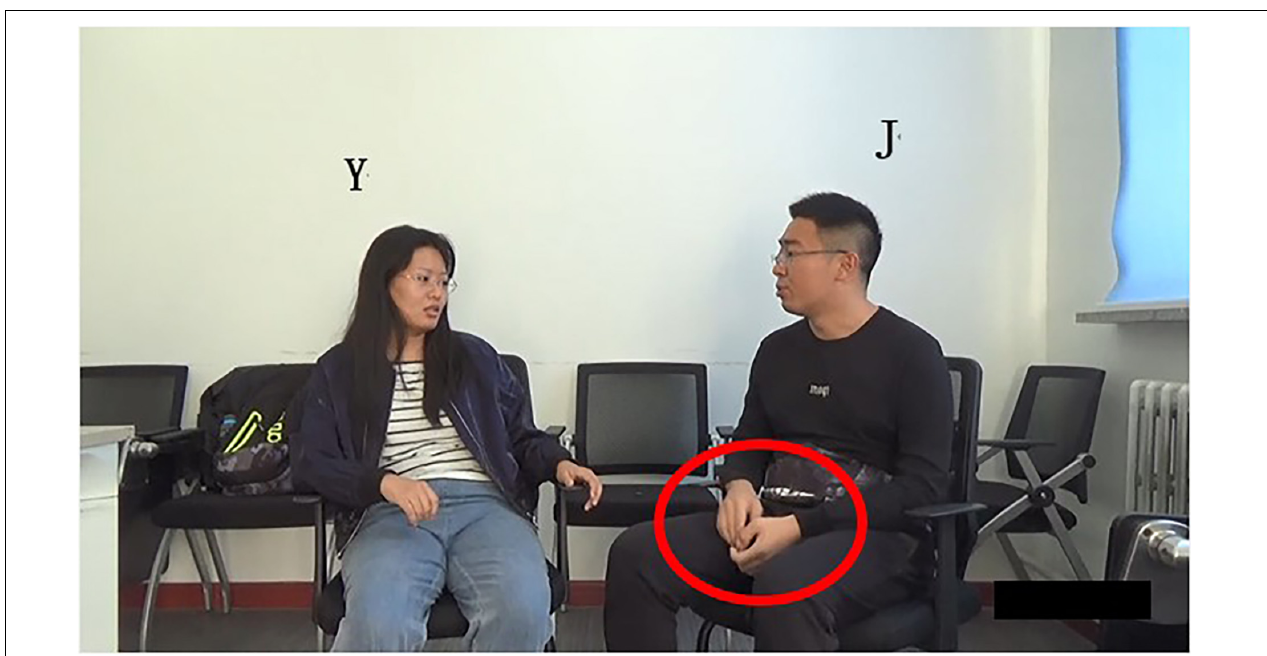
FIGURE 5 | Gesture of J after vertical bar in lines